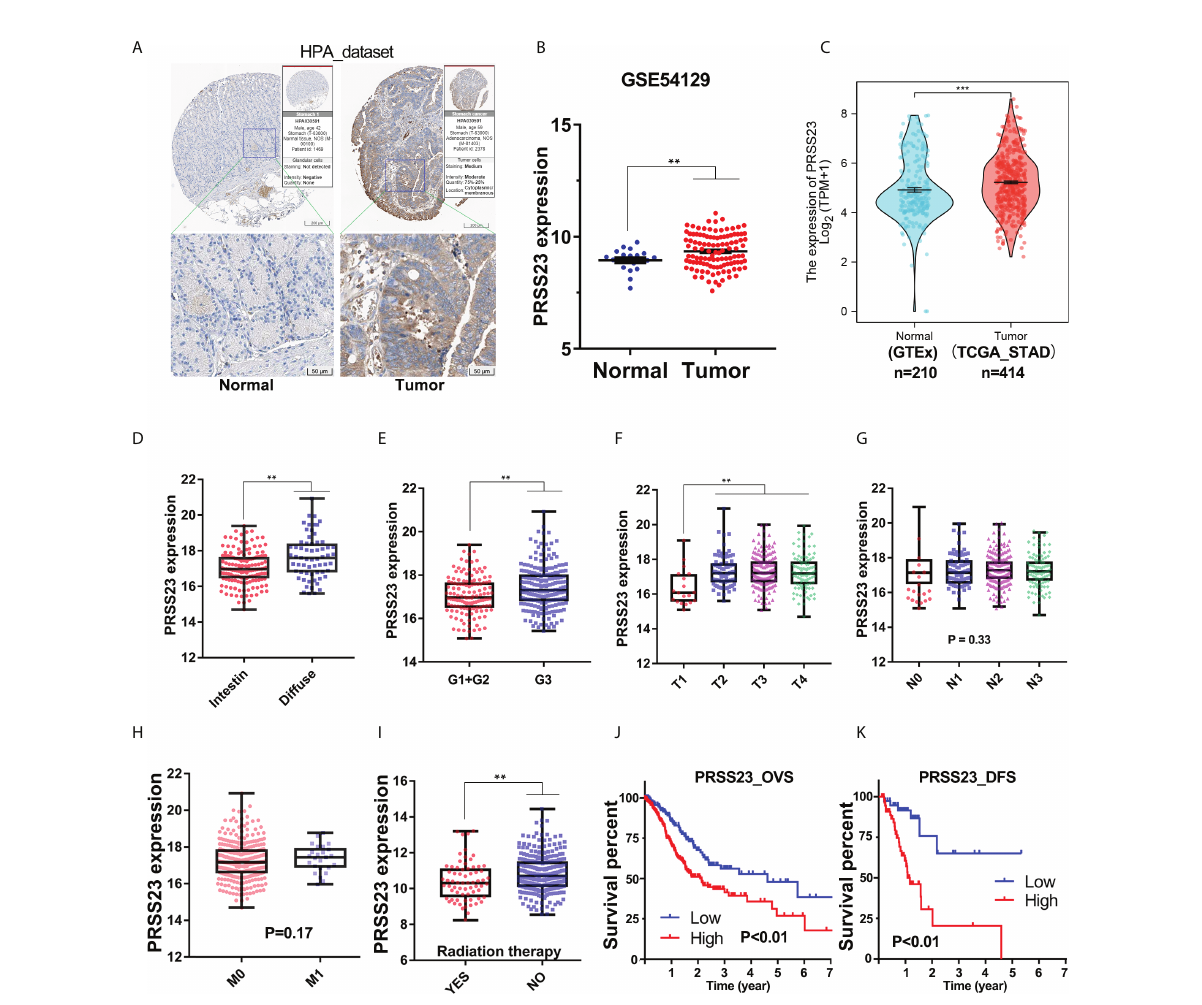
FIGURE 1 The clinical signi fi cance of PRSS23 overexpression was analyzed in the GC cohort from TCGA. (A) Differences in the immunostaining of PRSS23 between normal tissues and cancerous tissues in GC. (B, C) PRSS23 was overexpressed in cancerous tissues in the GSE54129 and TCGA_STAD cohort. (D) Differences in PRSS23 expression between intestinal and diffuse tissues of GC. (E) PRSS23 expression in GC tissues with different differentiation stages. (F – H) PRSS23 expression level in different TNM-stages of GC tissues. (I) PRSS23 was lowly expressed in GC patients with radiation therapy. (J, K) : PRSS23 overexpression predicted shorter overall survival time and disease-free survival time in GC. **, P < 0.01, ***, P <